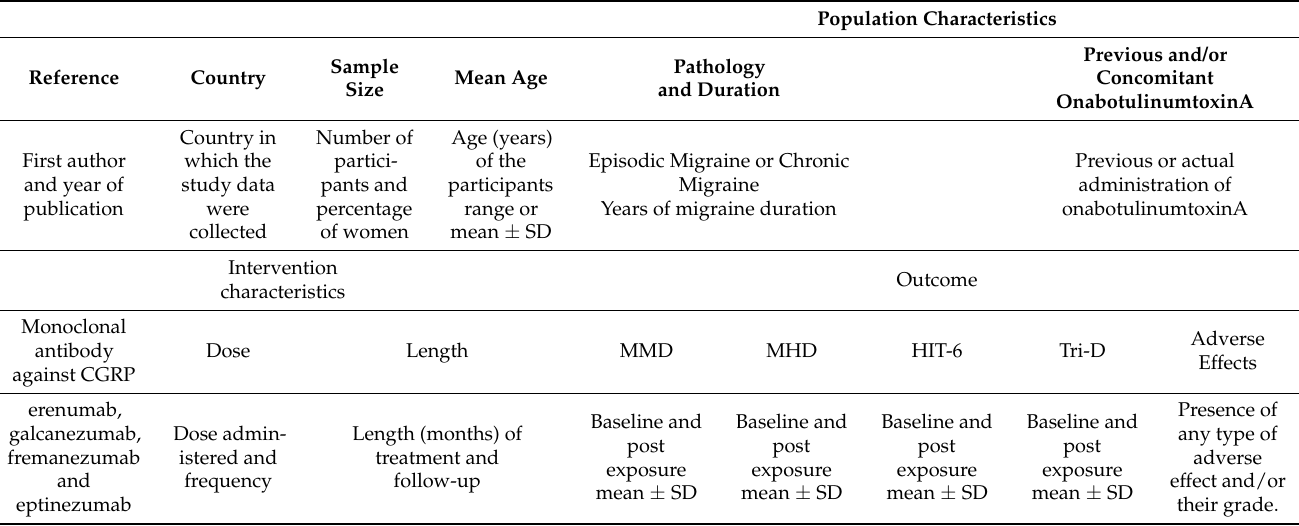
Table 1. Characteristics of studies